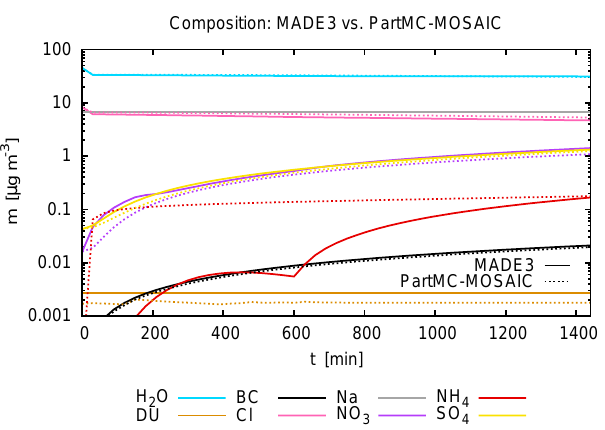
Figure 6. Temporal evolution of total aerosol species mass con- centrations in MADE3 (solid lines) and PartMC-MOSAIC (dotted lines). Abbreviations are as follows: BC for black carbon and DU for mineral dust. Note that the particulate organic matter (POM) concentration is below 0 . 001 µg m − 3 and therefore does not appear in the